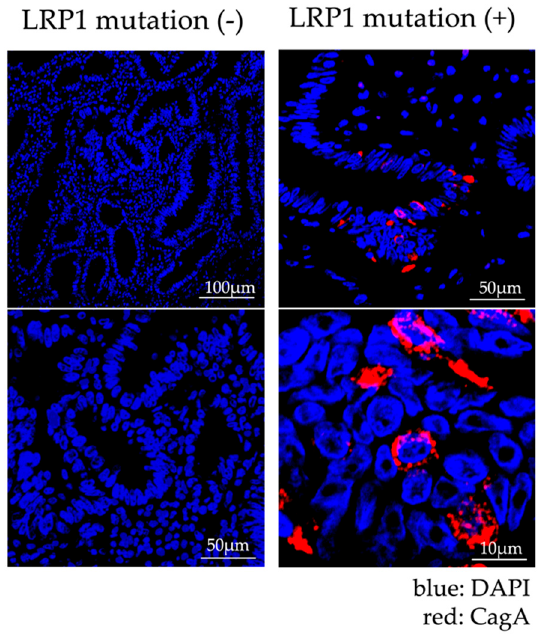
Figure 4. Immunofluorescence Staining of specimens treated by endoscopic submucosal dissection (ESD). The case with LRP1 mutation is shown on the right. CagA staining (red) was observed in the cytoplasm of gastric cancer cells in LRP1 mutant cases. On the other hand, the case without LRP1 mutation is shown on the left. CagA staining was not found in the cytoplasm of gastric cancer cells in cases without LRP1 mutation. DAPI (4’,6-diamidino-2-phenylindole) nuclear staining is shown in blue.